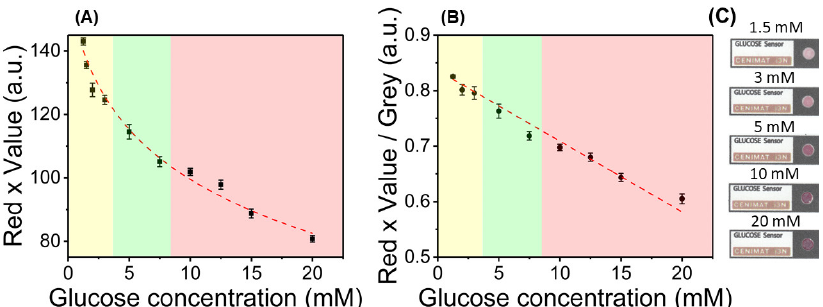
Figure 4. Calibration curves for the colorimetric, non-enzymatic paper-based assay. ( A ) Calibration curve using the combination of the Red and Value channels from RGB and HSV color spaces ( y = 163.89 − 26.65 ln( x + 1.20), r 2 = 0.9886, n = 6). ( B ) Linear calibration curve obtained by the ratio between the previous feature combination (R × V) and the grey scale value ( y = 0.836 − 0.013 x , r 2 = 0.982, n = 6). ( C ) Paper-based platform for assay performance, showing the color signals for different glucose concentrations.